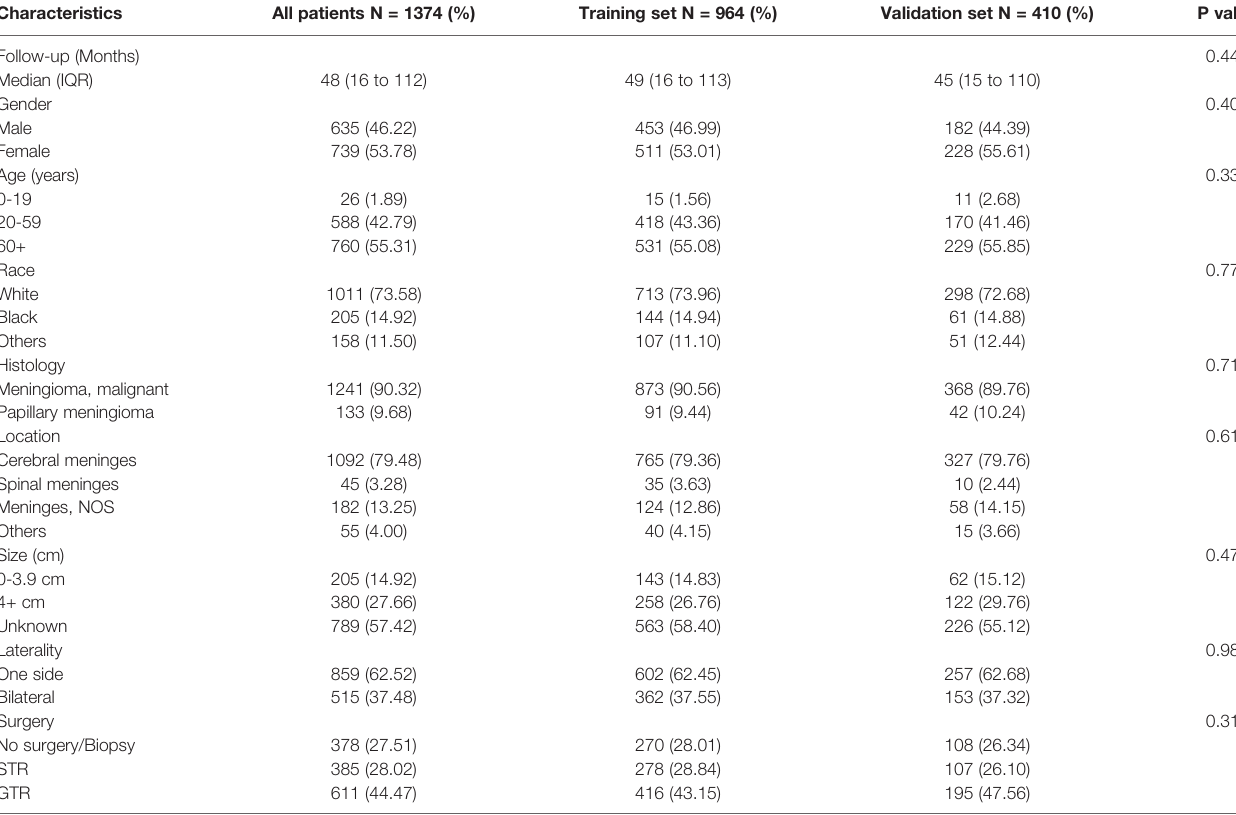
TABLE 1 | Baseline characteristics of WHO Grade III meningioma patients from SEER database.